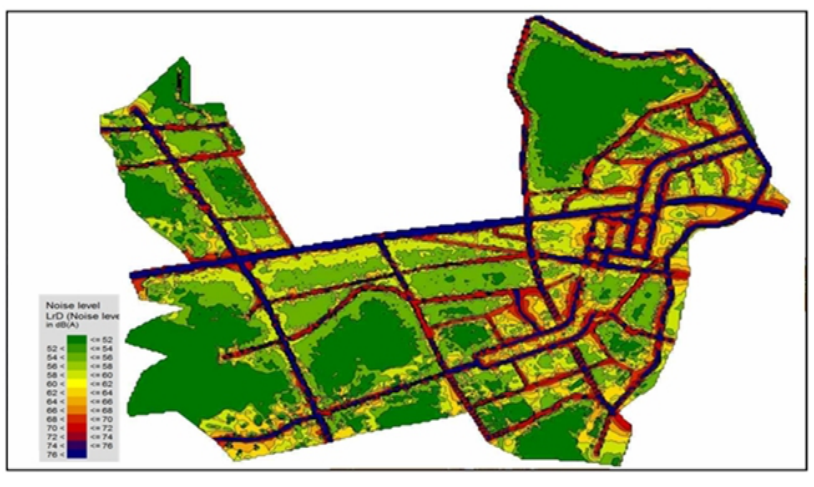
Figure 1. Grid distribution type noise map in whole